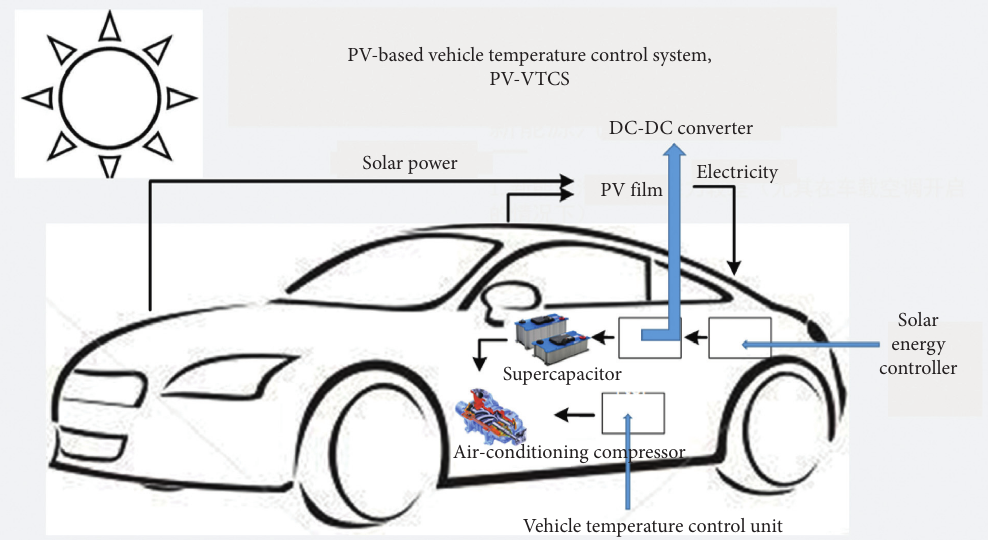
Figure 1: PV-based vehicle temperature control